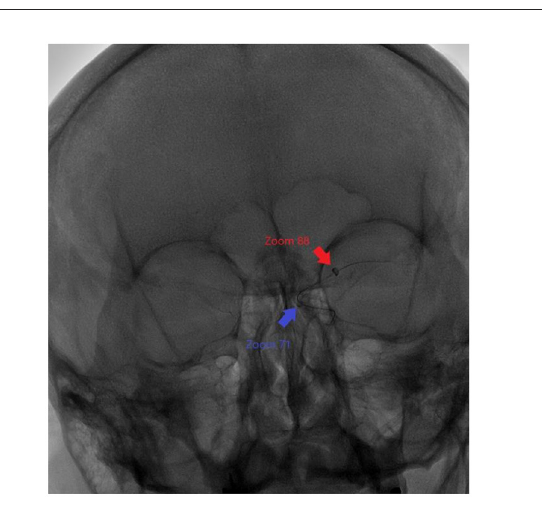
FIGURE4 Relative positions of Zoom 88 and Zoom 71 catheters to each other during the mechanical thrombectomy procedure.